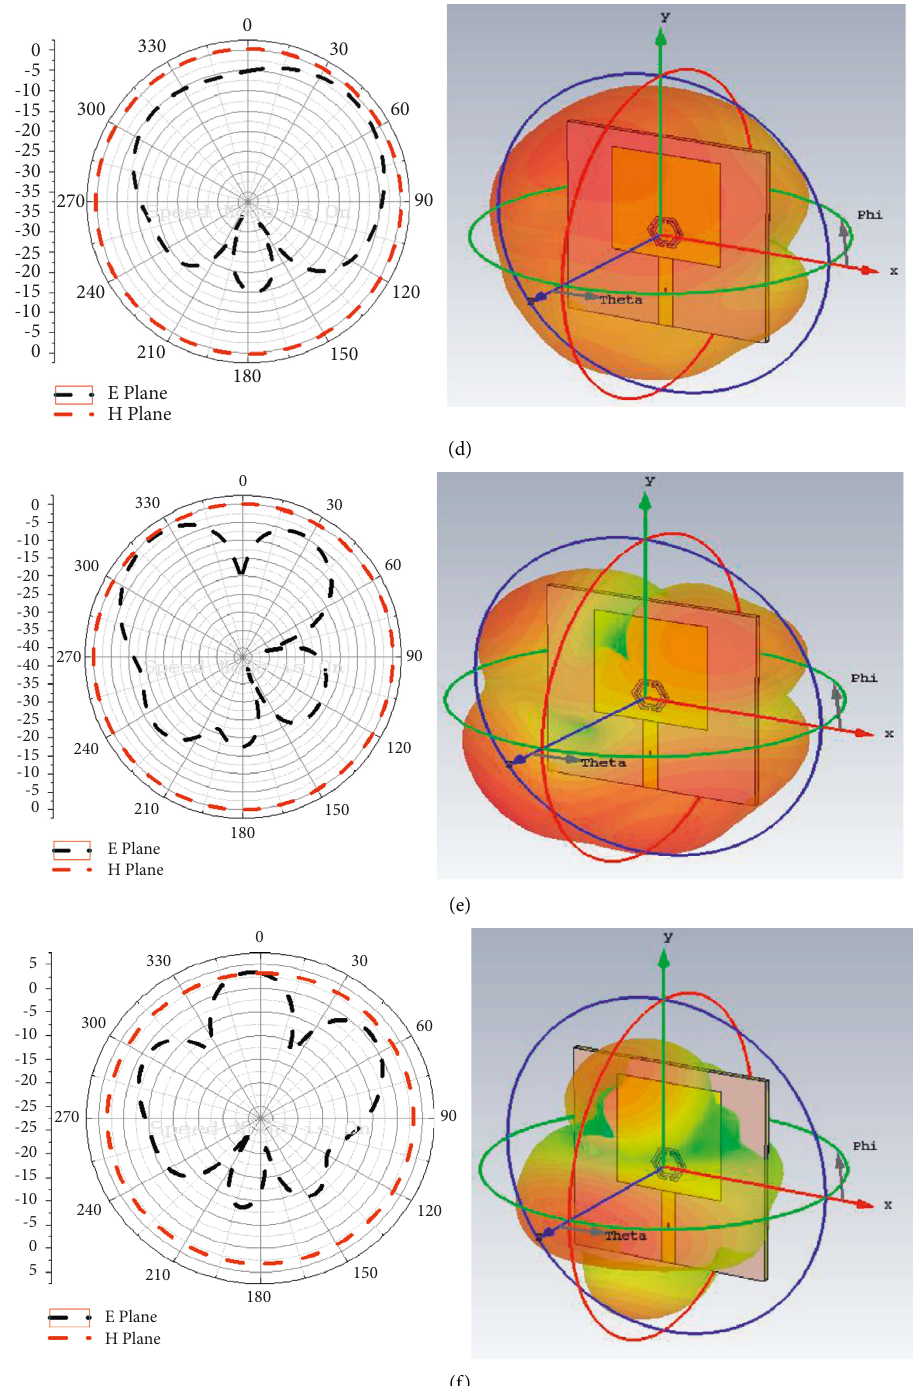
Figure 11: Radiation pattern at various resonating frequencies. (a) At 2.1 GHz, (b) at 2.6GHz, (c) at 4.6 Hz, (d) at 5.5GHz, (e) at 6.1 GHz, and (f) at